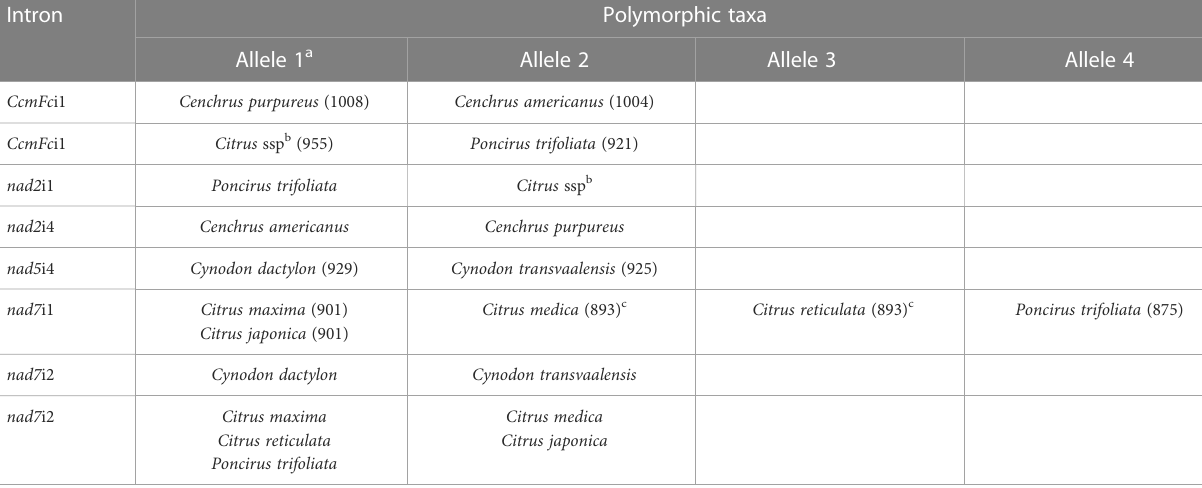
TABLE 5 Experimentally identi fi ed intron length polymorphisms between congener species.